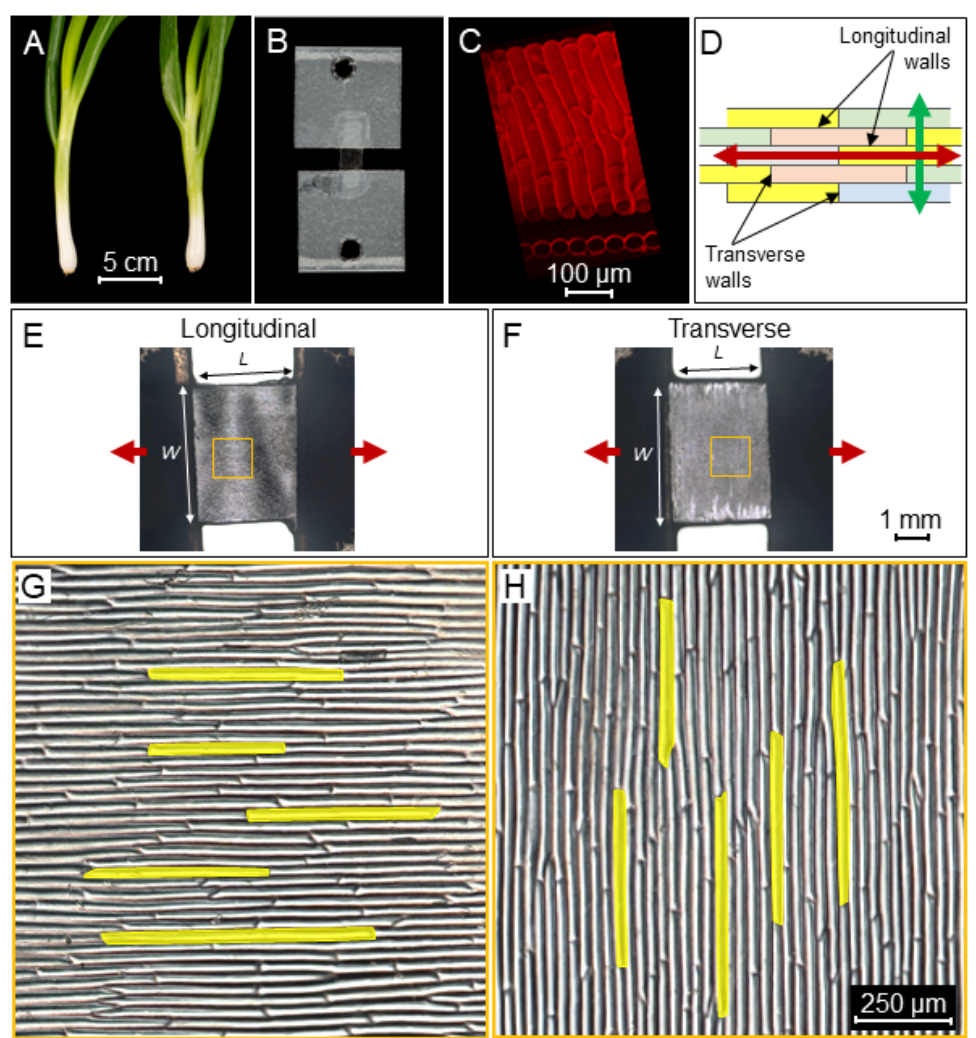
Figure 1. Preparation of longitudinal and transverse sections for tensile testing with a microexten- someter. ( A ) The adaxial onion epidermal peel was obtained from white bulbs of spring onions. ( B ) Experimental setup of onion epidermal samples attached to Tough-Tags™ for tensile testing. ( C ) The morphology of onion epidermal cells stained with propidium iodide: surface view (top), cross section (bottom). ( D ) The anisotropic cells displaying longitudinal and transverse cell walls were stretched in the longitudinal (red arrow) and transverse (green arrow) directions. ( E – H ) Images showing samples for tensile testing arranged in the longitudinal ( E , G ) and transverse ( F , H ) directions. Red arrows indicate the direction of stretching. ( E , F ) Samples were carefully sectioned and measured before the experiment to retain similar size between the two stretching directions. ( G , H ) Close-up of the samples from the yellow squares (in E , F ), with visible single-cell outlines indicate that the two samples ( E , G ) and ( F , H ) consist of cells, which are similar in size. Examples of cell outlines are highlighted in yellow. Scale bars are displayed in the figure.